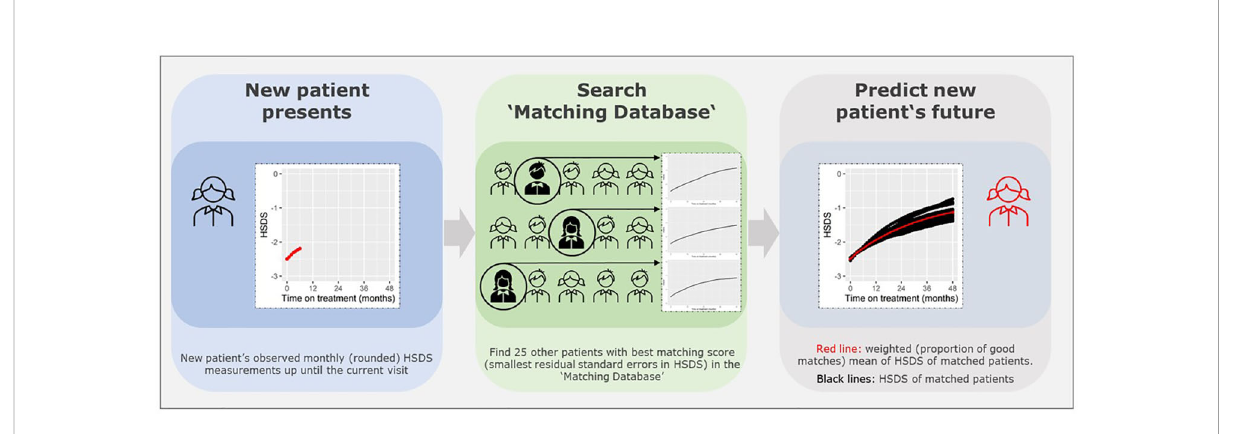
FIGURE 1 Technique to fi nd matches based on similar growth